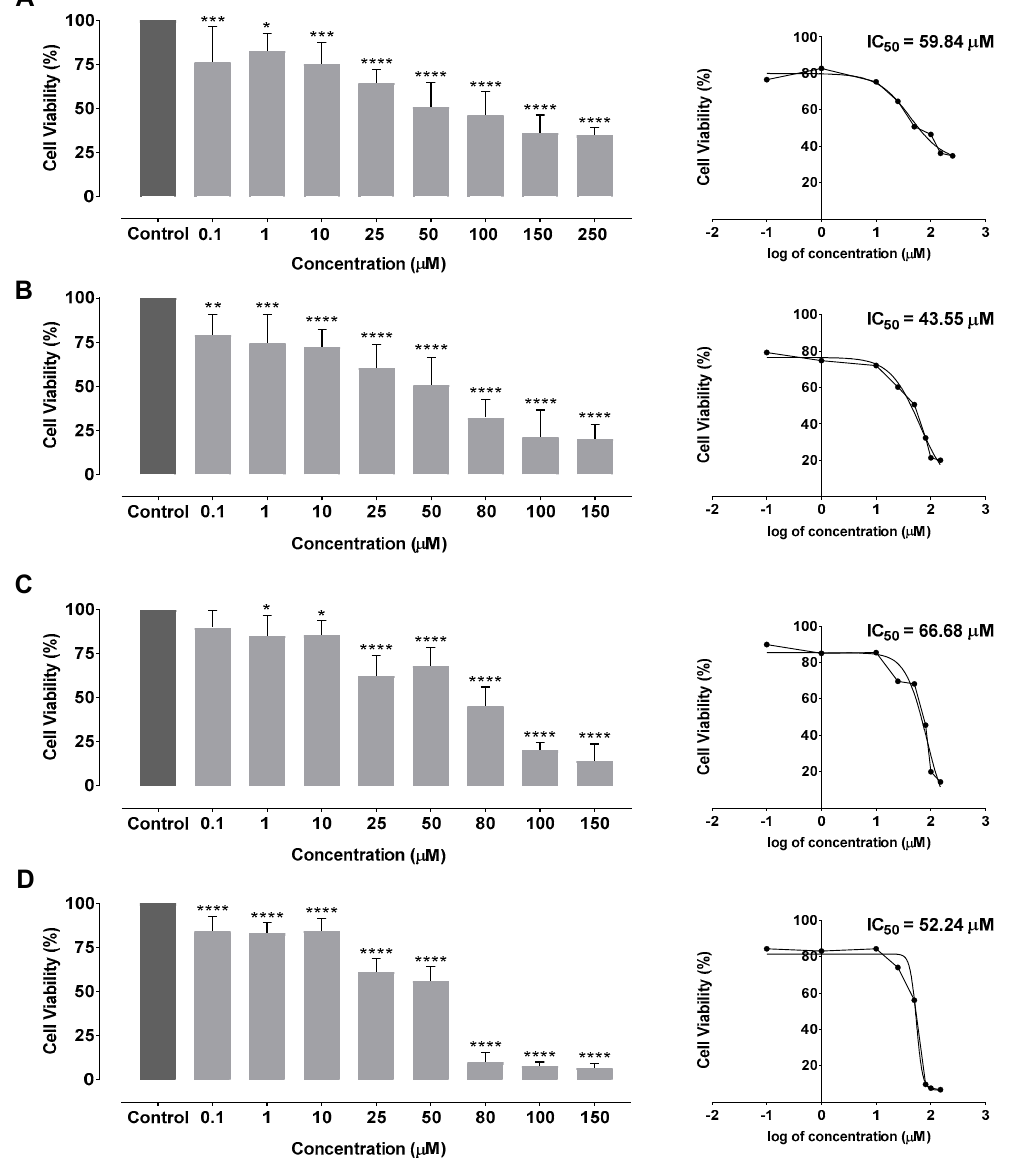
Figure 6. Cellular viability and dose-response curves on HeLa cells after 48 h incubation by MTT assay for ( A ) free quercetin; ( B ) HMW chitosan/SBE– β –CD/quercetin delivery systems; ( C ) LMW chitosan/SBE– β –CD/quercetin delivery systems; and ( D ) 5 kDa chitosan/SBE– β –CD/quercetin delivery systems. Non-transfected cells were used as control. Free quercetin and delivery systems were tested between the concentration range of 0.1 µ M and 250 µ M. Data are presented as mean ± SD for three independent experiments (n = 3) with four technical replicates and analyzed by one-way ANOVA with the Bonferroni test. Significance was determined as p -values * <0.05, ** <0.01, *** <0.001, **** <0.0001.